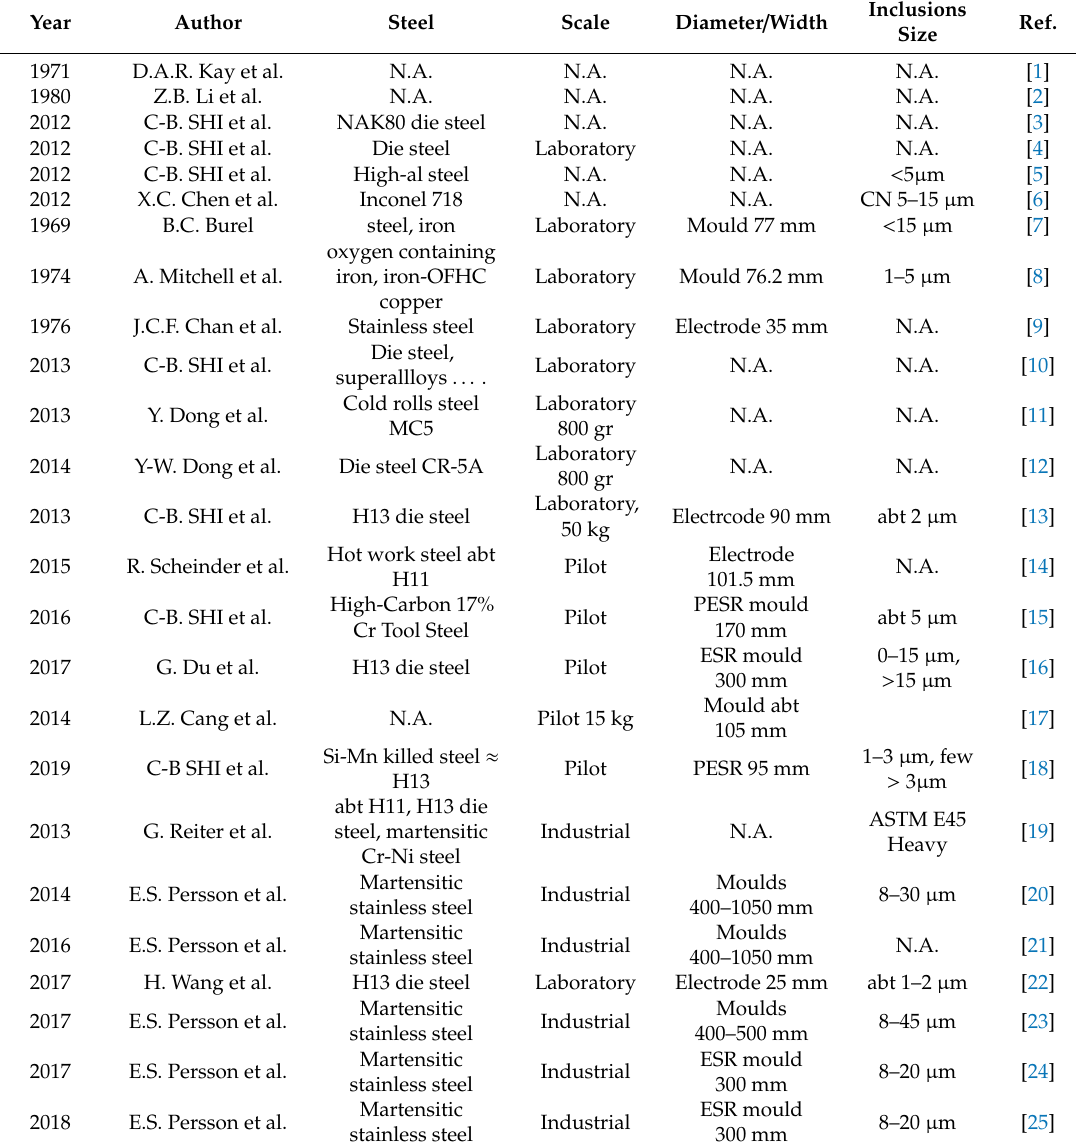
Table 1. Previous studies on inclusions in electro-slag remelting (ESR) or electro-slag remelting under protective pressure controlled atmosphere (PESR)